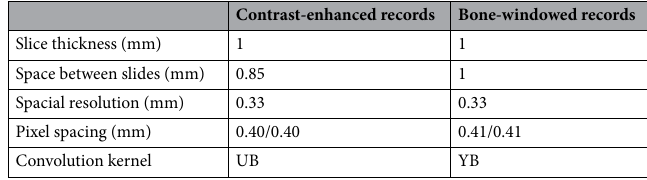
Table 3. CT specifications regarding contrast-enhanced and bone-windowed